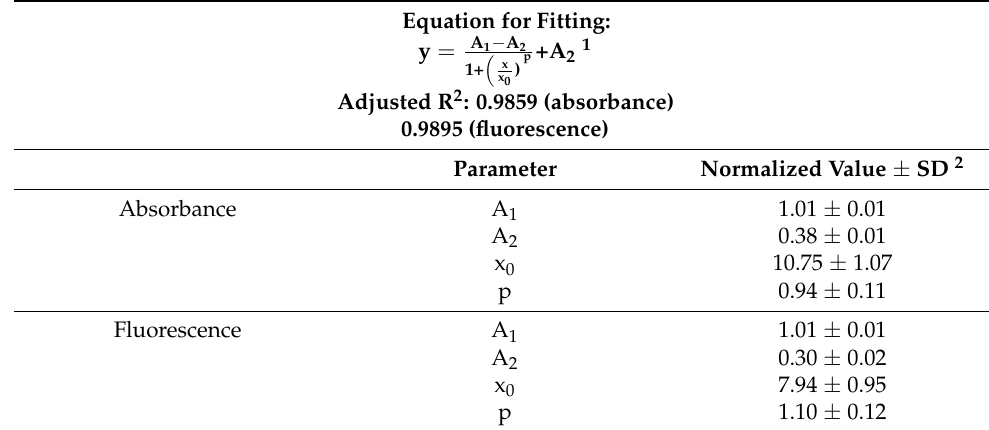
Table 1. Statistical parameters of the calibration curve obtained for a glyphosate concentration range of 0–100 ng/mL based on the Rodbard equation. Parameters are presented for absorbance and fluorescence, respectively.